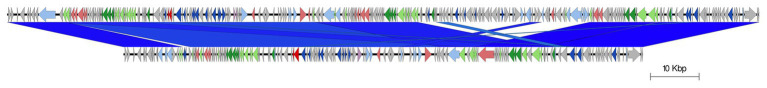
Easyfig alignment of prophage 8 (stx2a) for both query samples (818062; top and 824422; below). Arrow indicates gene direction. Recombination/replication genes shown in light blue, Stx genes shown in red, regulation associated genes in dark blue. Structure and lysis associated genes shown in light and dark green, respectively, finally gray are hypothetical genes.